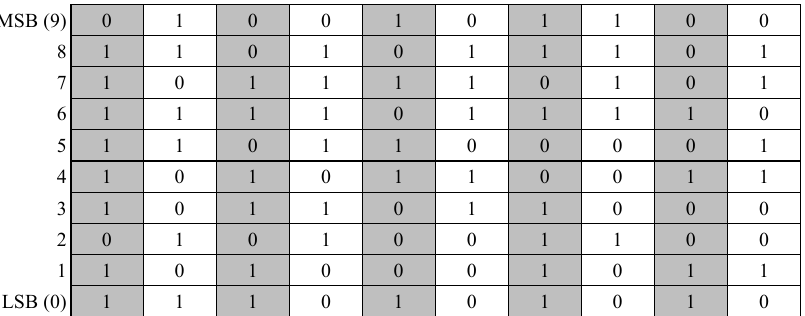
Table 1. An example of a binary matrix of